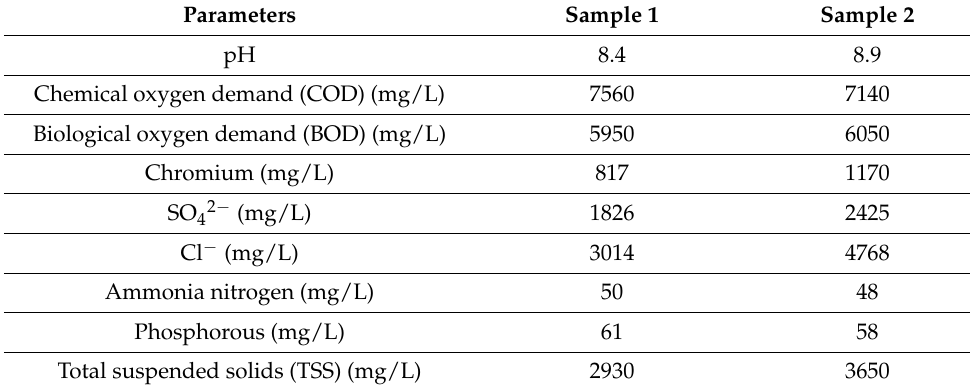
Table 7. Physicochemical analysis for real tannery wastewater samples.